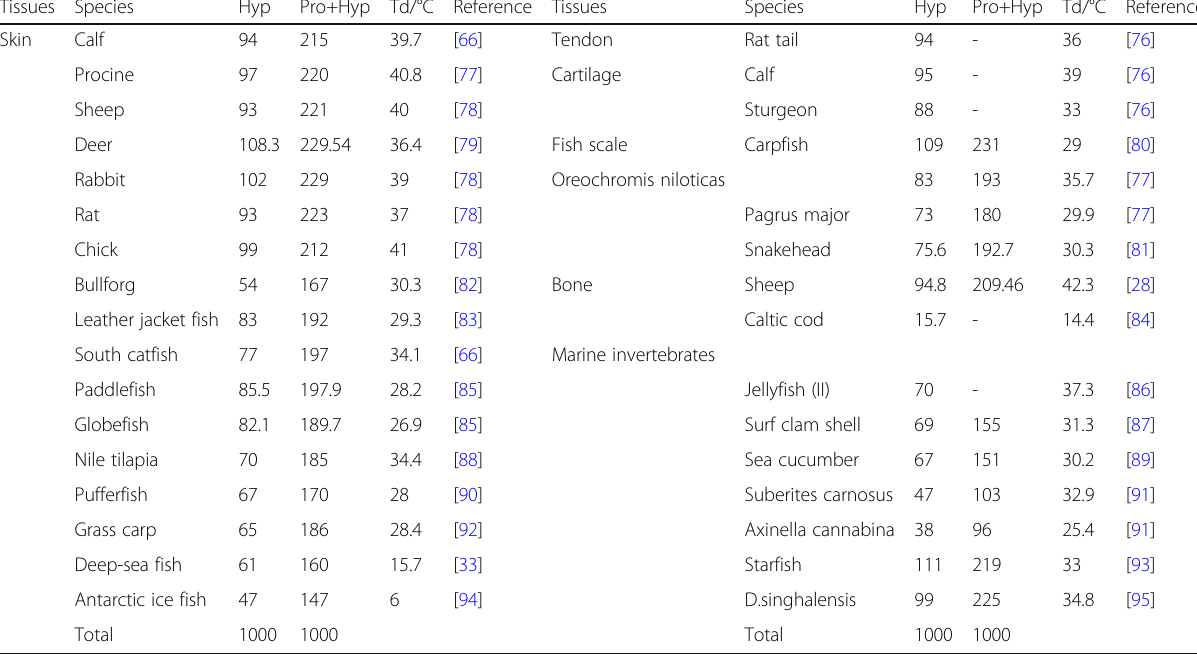
Table 2 Hydroxyproline content (residues/1000 total residues) and denaturation temperature (Td) of collagen from various species Tissues Species